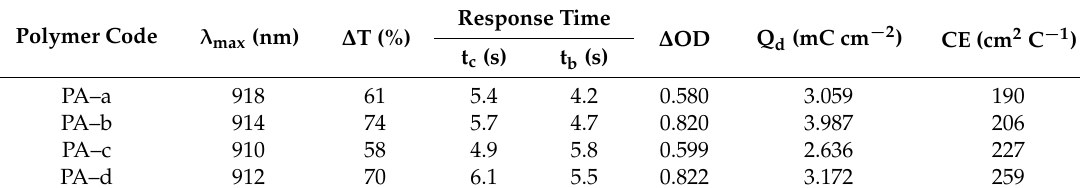
Figure 5. The electronic absorption spectrum of film of PA–a ( a ); PA–b ( b ); PA–c ( c ) and PA–d ( d ) was carried out in 0.1 M Bu 4 NClO 4 /ACN as the supporting electrolyte.